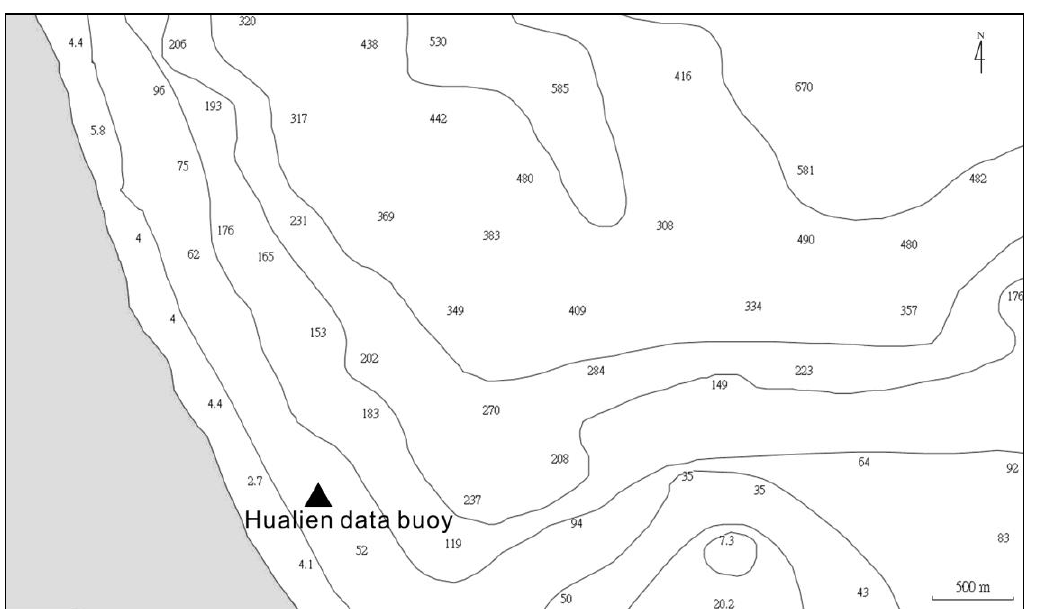
Figure 7. The location and surrounding bathymetry of buoy station. The numbers inside the figure stand for water depths. The water depth of buoy location is 30